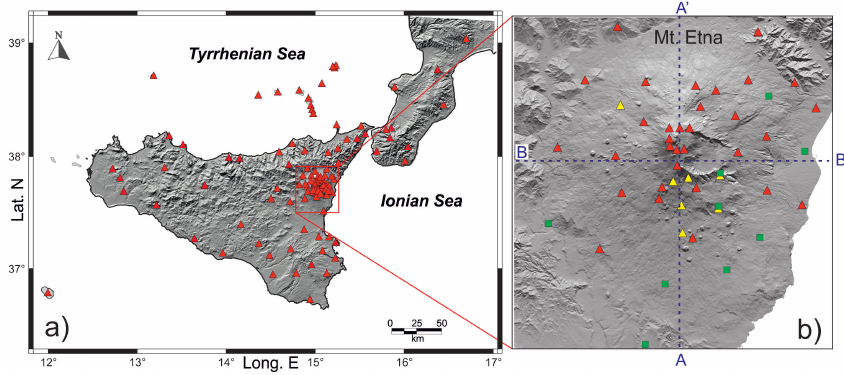
Fig. 1. (a) Seismic stations currently deployed in Sicily and the Southern Calabria (Italy) and detail of Etna volcano; red triangles are digital stations; yellow triangles are analogical stations; green squares are candidate sites; blue dashed lines indicate the cross sections AA 0 and BB 0 reported in Figs. 8 and 9 (see text for more